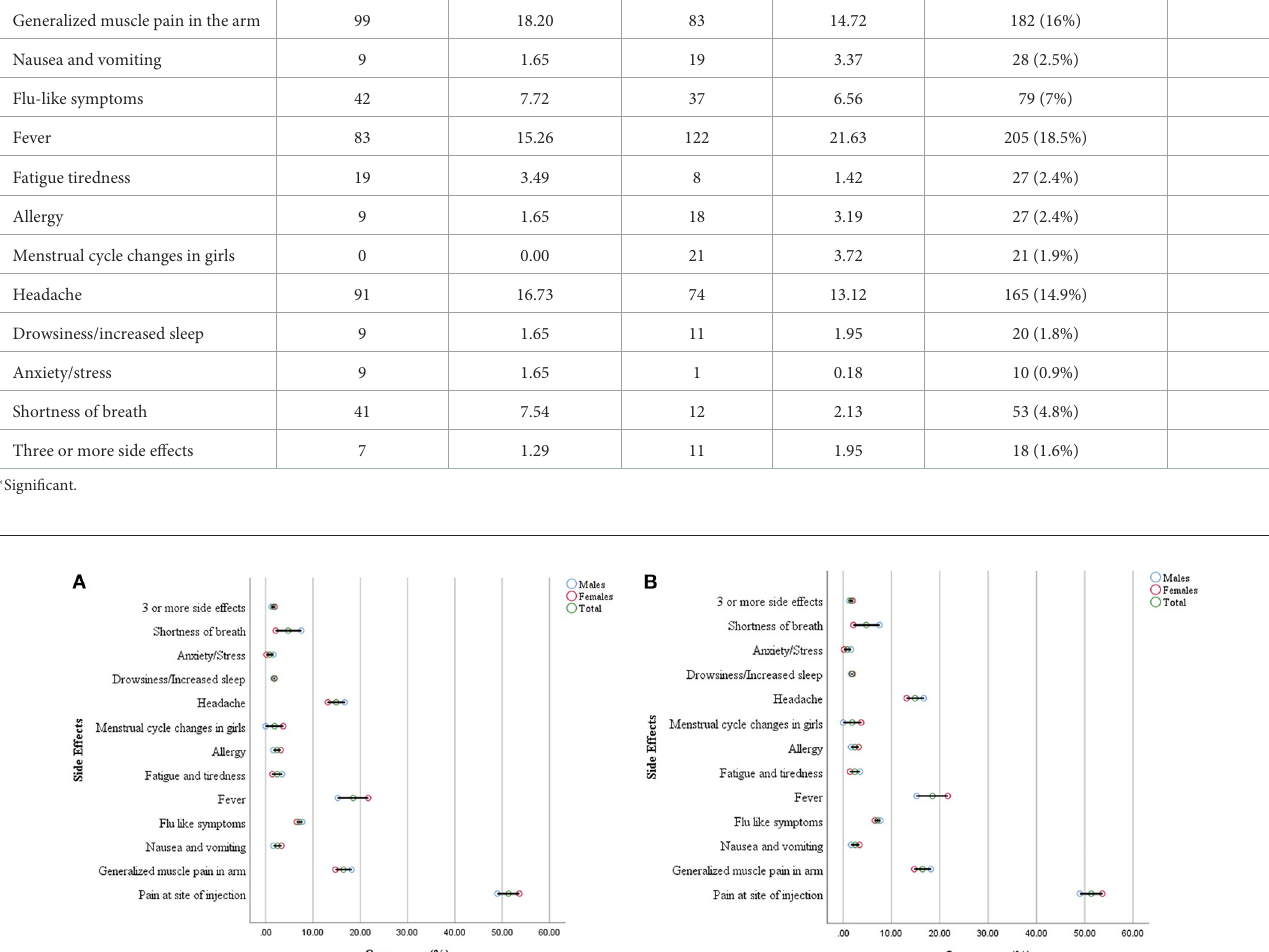
who received two doses (i.e., 57.9%) compared to males (i.e.,